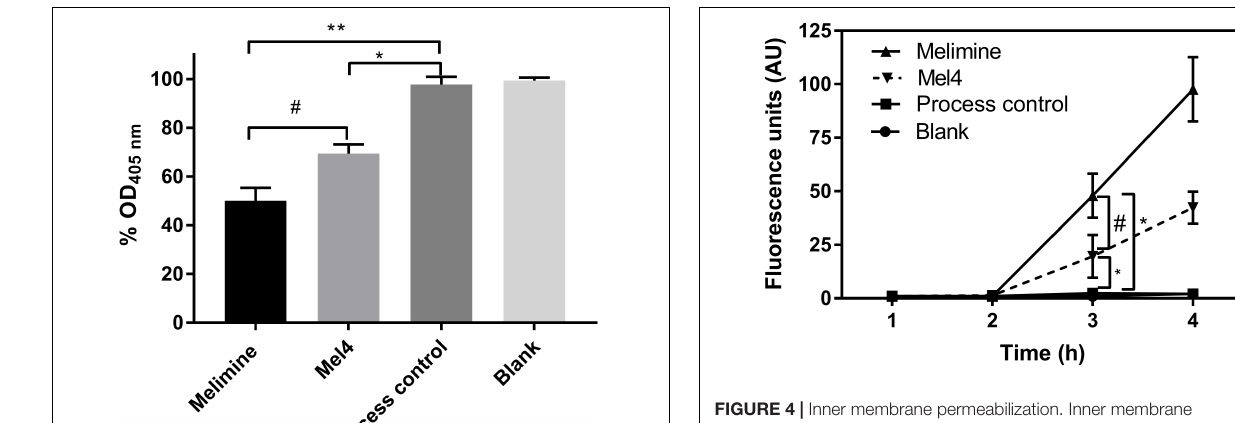
FIGURE 4 | Inner membrane permeabilization. Inner membrane permeabilization of P. aeruginosa 6294 by surface attached melimine and Mel4 was determined using the membrane impermeable dye Sytox green. Fluorescence intensity due to interaction of Sytox green with DNA following incubation with peptides attached to surfaces was measured spectroscopically at 480 nm excitation and 522 nm emission wavelengths. * p < 0.001 compared to process control while # p = 0.007 compared to Mel4. Error bars represent means ( ± SD) of three independent repeats in triplicate.